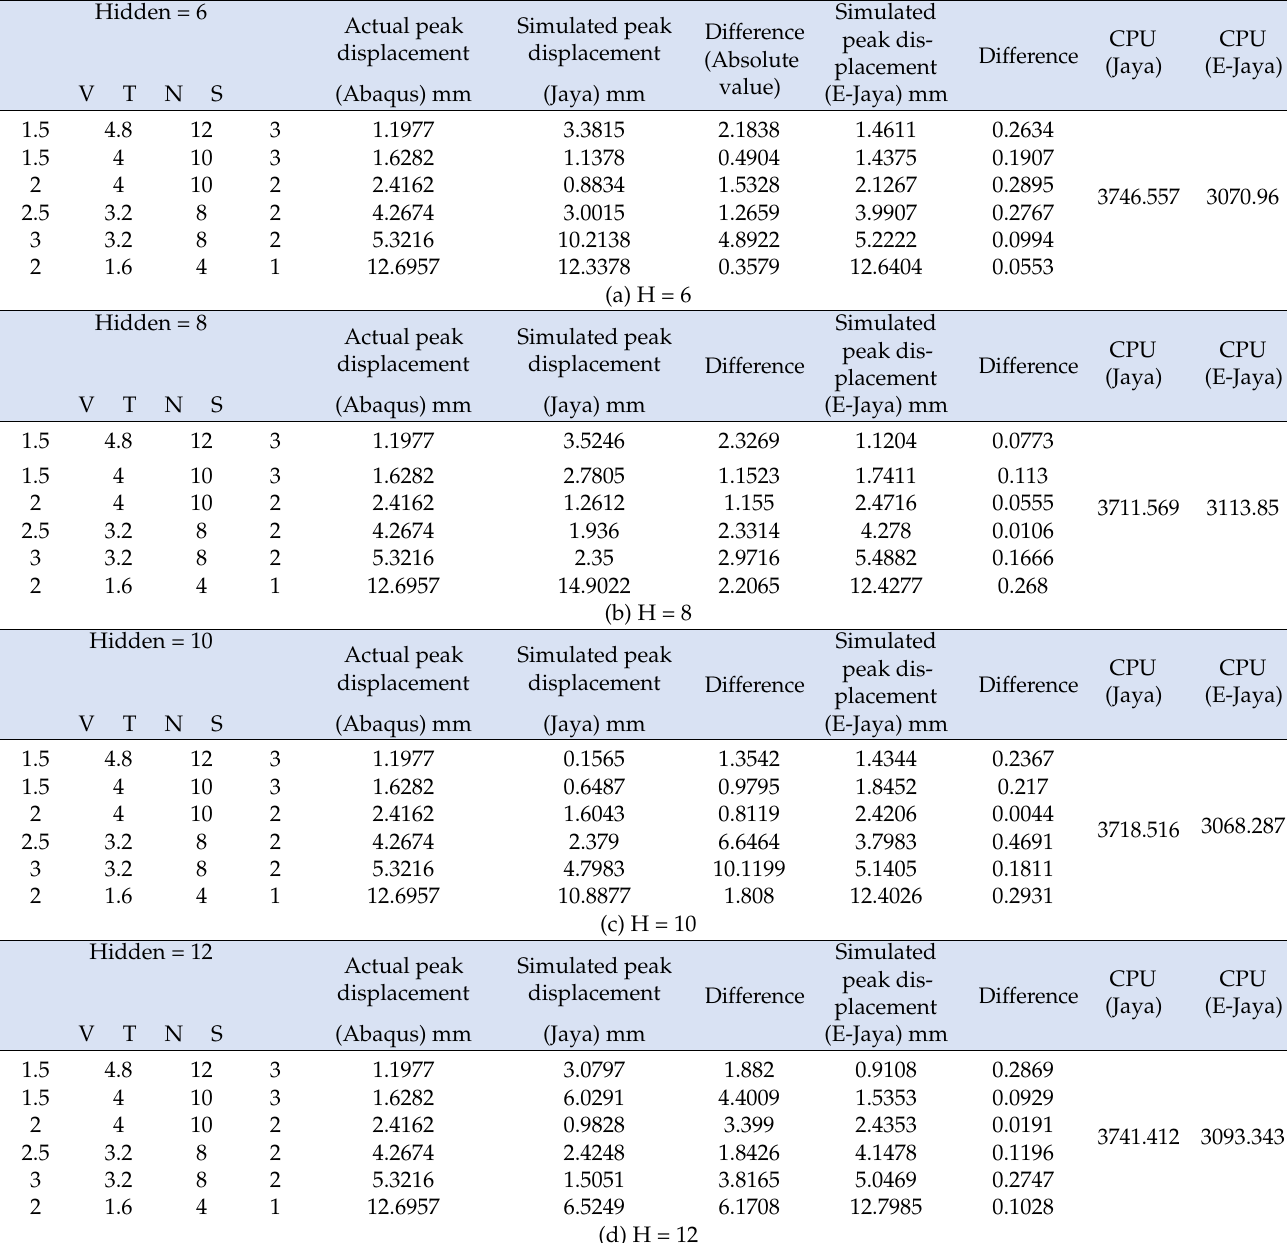
Table 4. Independent scenarios to verify Jaya and E-Jaya model: (a) H = 6, (b) H = 8, (c) = 10 and (d) =